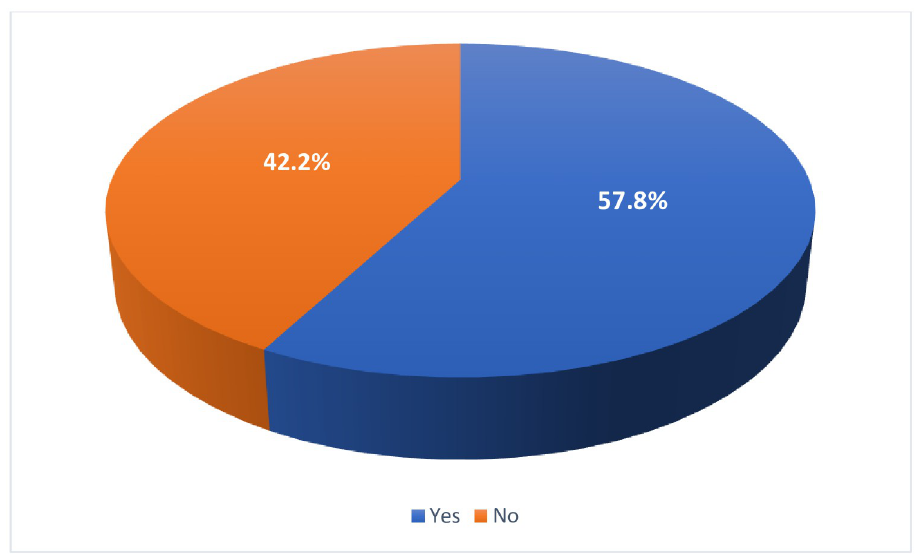
Fig 1. Frequency distribution of participants who have/would vaccinate child/ren against COVID-19 ( n = 500).